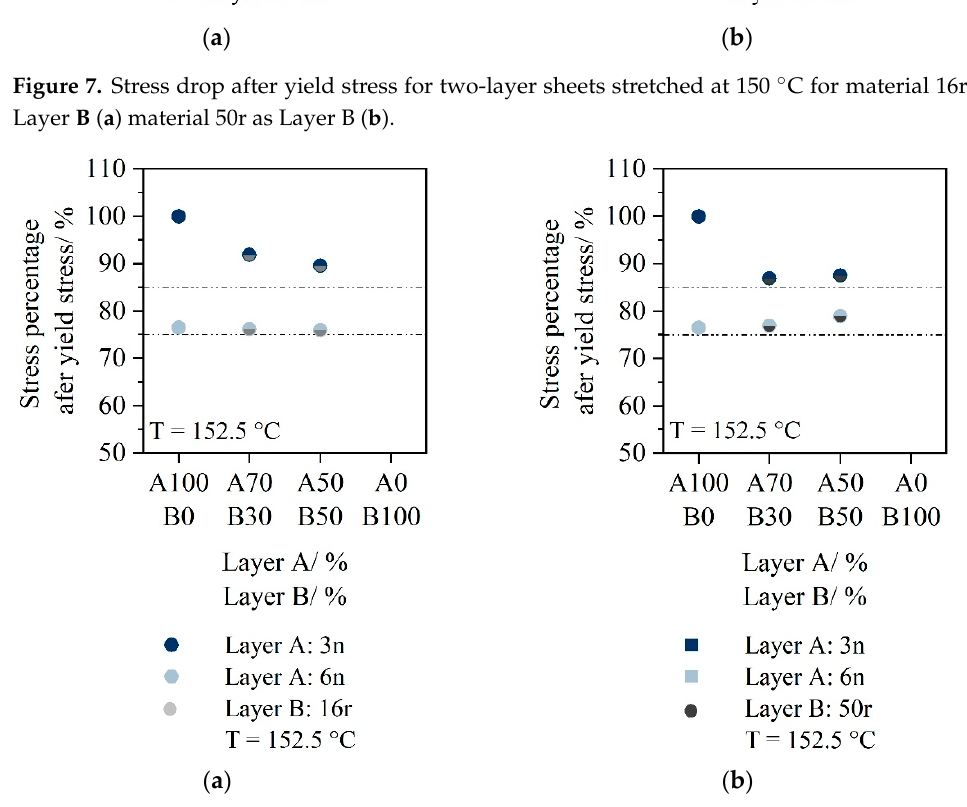
Figure 8. Stress drop after yield stress for two-layer sheets with material 16r as Layer B ( a ); stress drop after yield stress for two-layer sheets with material 50r as Layer B ( b ).